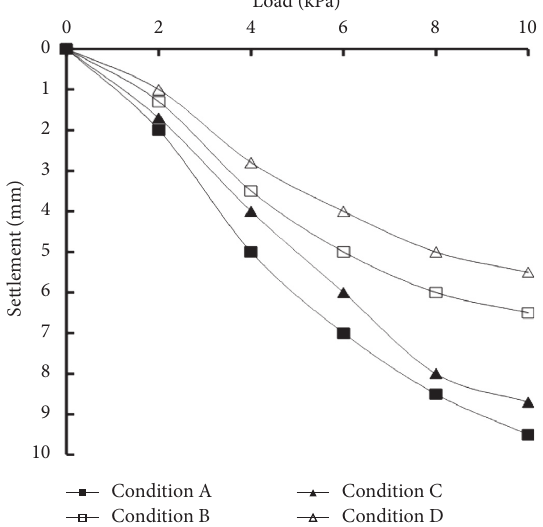
Figure 10: P–S curve at trapezoidal filling structure toe of slope under four testing conditions.